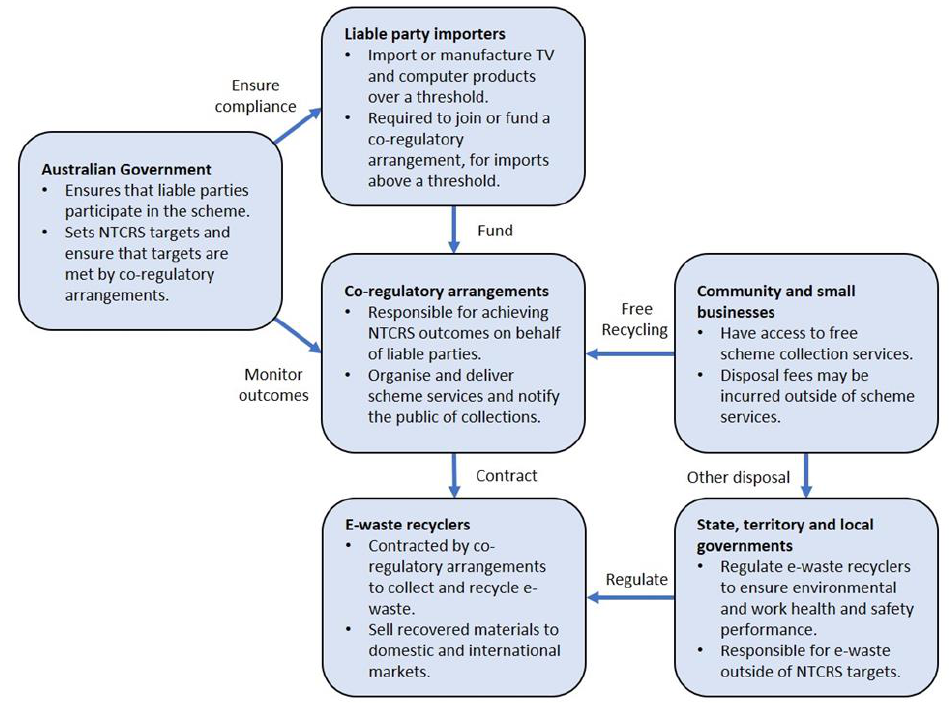
Figure 5. Overview of the roles and responsibilities for various stakeholders of the Australian National TV and Computer Recycling Scheme (NTCRS) modified from [39].